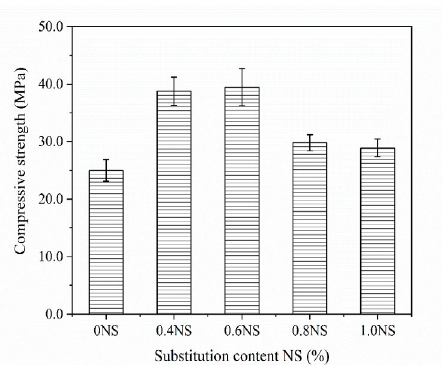
Figure 9. Compressive strength of cement pastes with NS at 28